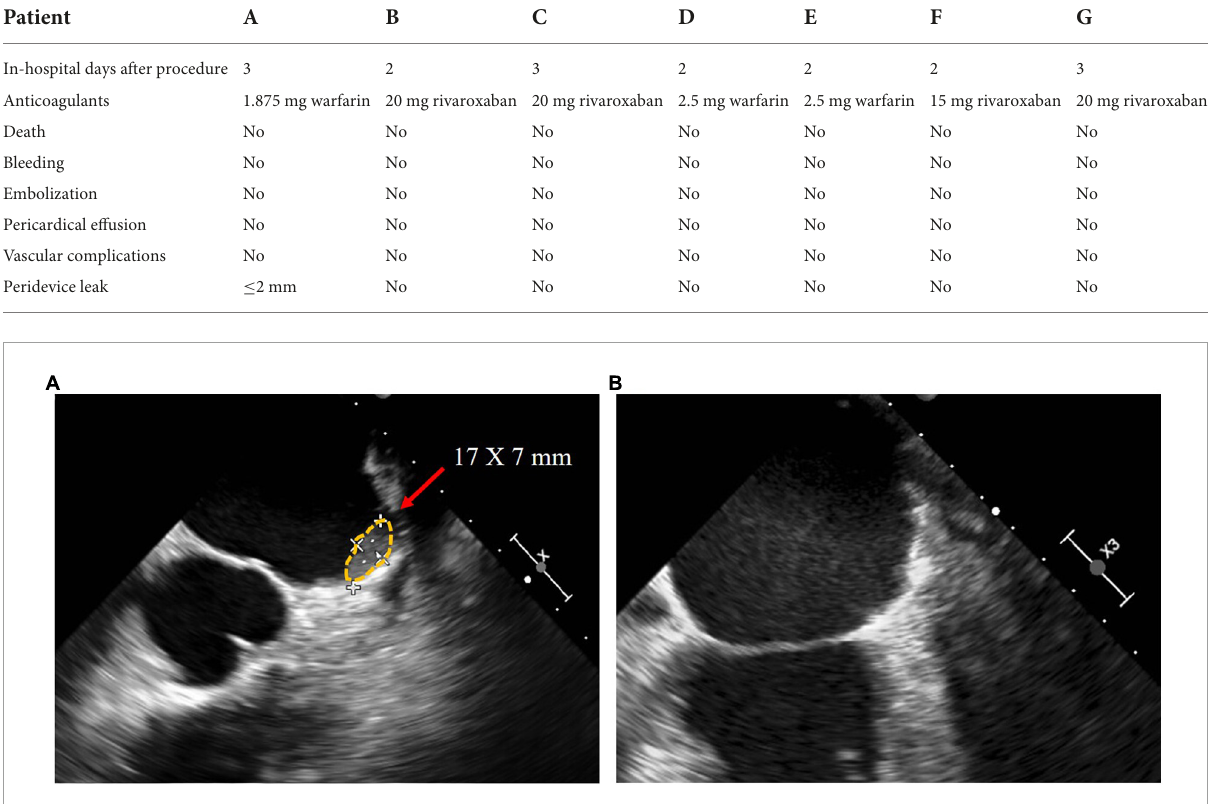
FIGURE4 In the transesophageal echocardiography images of patient B, (A) DRT of 17*7 mm was detected 14 months postoperatively, and (B) DRT dissolved after 5 months of 2.5 mg warfarin once